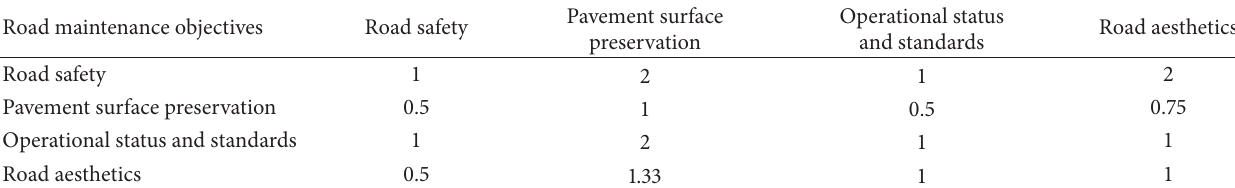
Table 8: Averaged AHP based evaluation matrix for the maintenance objectives.